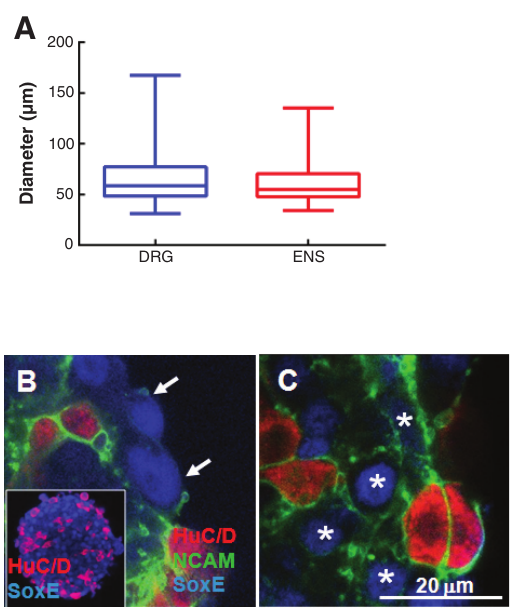
Figure 9. QE8 DRG cell aggregates in vitro have different internal structure than ENS cell aggregates. A . QE8 DRG and ENS HNK-1 +ve cell aggregates were similar in average size and size distribution. Box plots show the first quartile to inter quartile range and whiskers show minimum and maximum range of data, while the median is represented by a vertical line. There was no difference between DRG and ENS in aggregate size when analysed using Mann-Whitney test for nonparametric data. Starting cell density was 0.5 ×10 6 cells/ml. B . Unlike QE8 ENS cell aggregates, Hu +ve neurons and SoxE +ve cells are not segregated in DRG aggregates (inset), but like ENS aggregates, peripheral SoxE +ve cells show little outer NCAM labelling (arrows). C . In contrast, internal SoxE +ve cells (stars) as well as surface and internal Hu +ve cells show strong NCAM labelling in DRG cell aggregates.